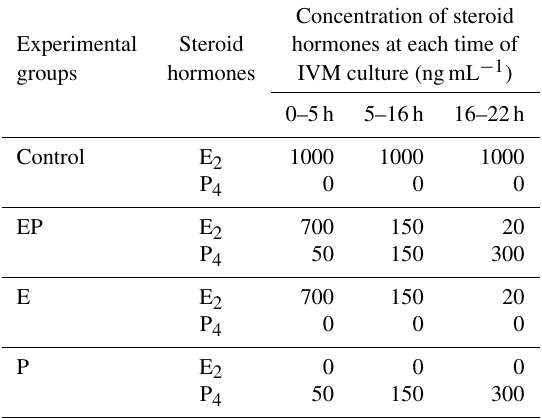
Table 1. Three-step IVM culture of bovine